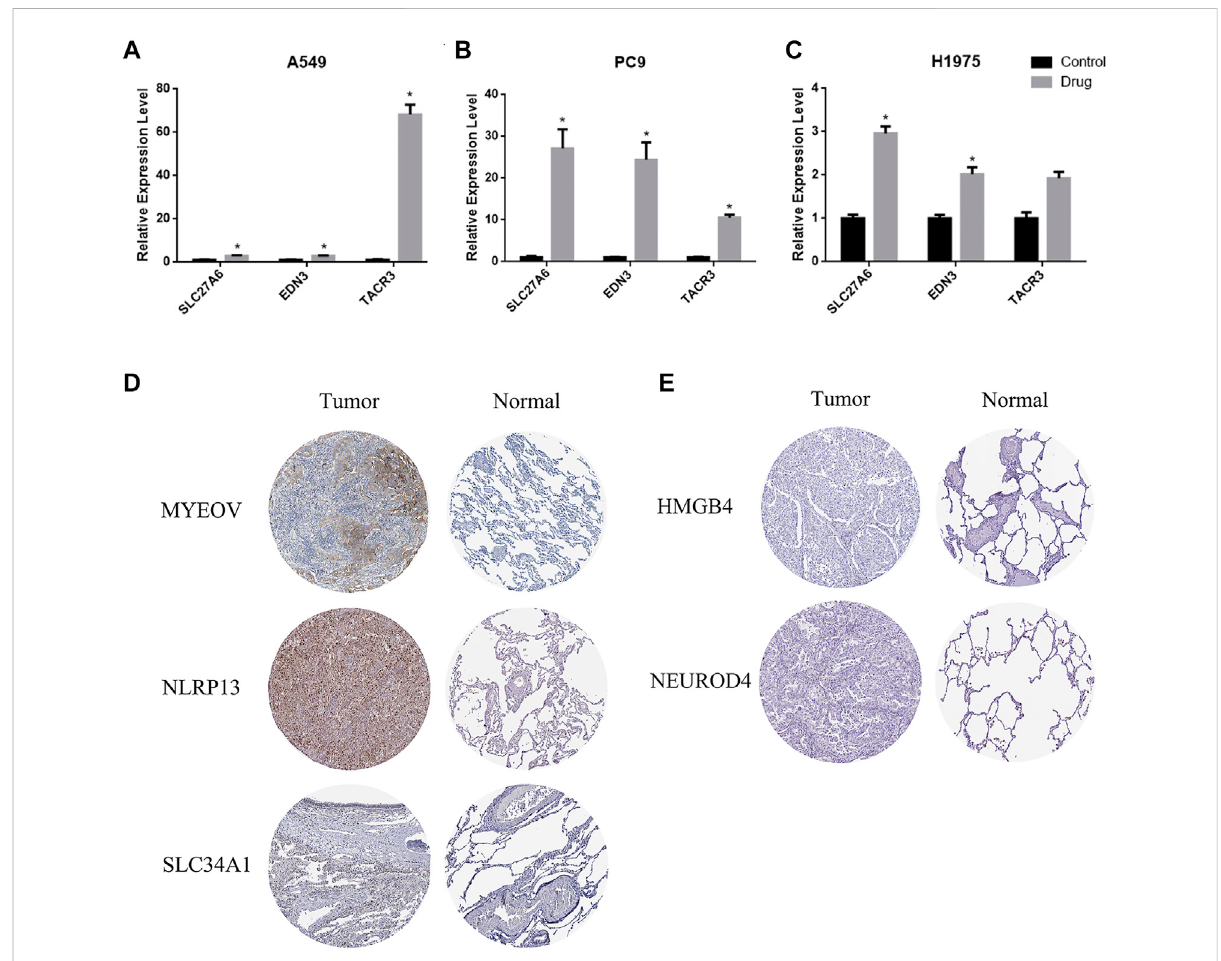
FIGURE 7 The expression of TACR3, EDN3 and SLC27A6 is related to promoter region methylation. (A – C) qPCR was used to detect the mRNA levels of TACR3, EDN3 and SLC27A6 in A549, PC9 and H1975 cells before and after the 5-Aza-2 ′ -deoxycytidine treatment. (D – E) Immunohistochemistry images obtained from the HPA database demonstrated the protein expression of the 5 hypomethylated